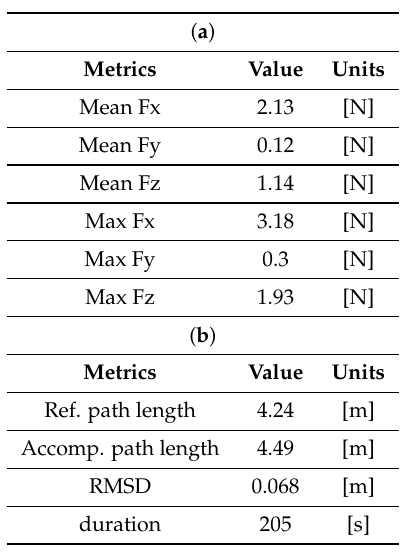
Figure 15. Path replanning experiment depicted in different views. ( a ) Executed path until the moment when the obstacle is introduced and detected. The red color depicts a detected possible collision. ( b ) 3D replanned path from the new start position (position reached in ( a )). ( c ) Side view of the mine tunnel with the obstacle between start and goal position of the robot. Tunnel walls are depicted in green, the obstacle in blue, and gray circles depicts the final planned path. Table 5. Key figures of the path replanning experiment performed in SIL. ( a ) Mean and max force reference commands obtained by FL controller. ( b ) Length of the reference path and the accomplished path, RMSD, and the duration of the